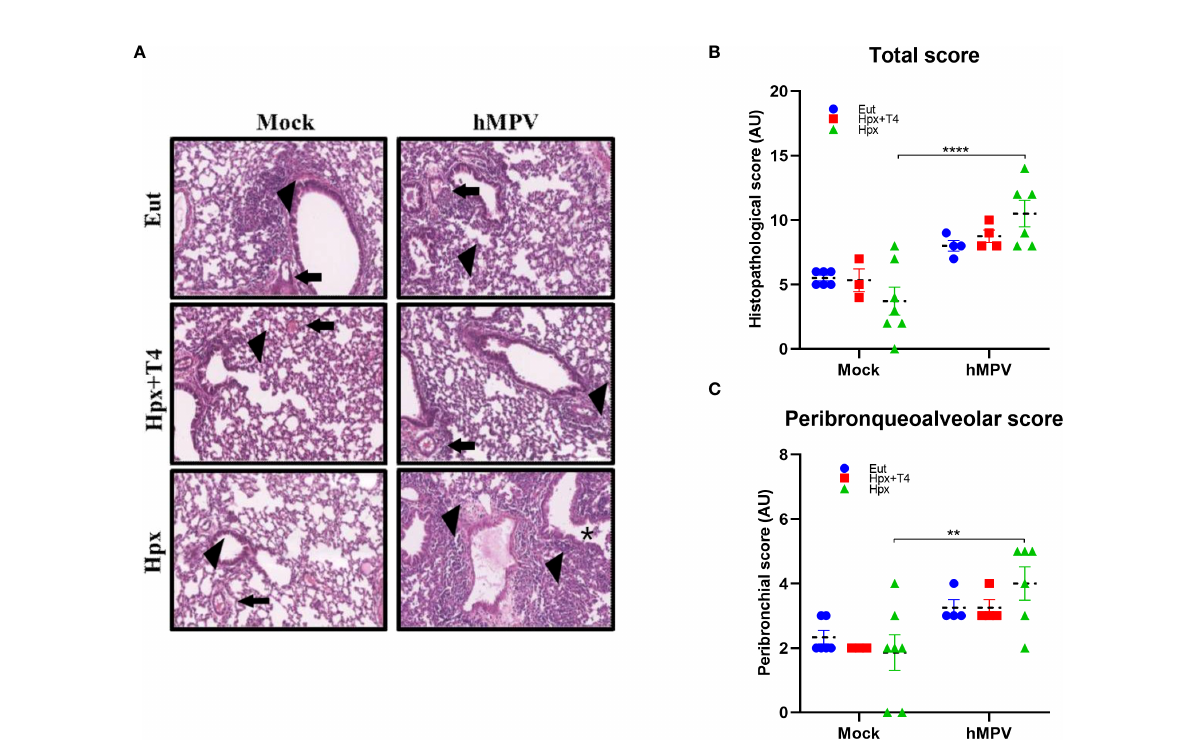
FIGURE 4 Hpx progeny tends to have a higher histopathological score after the hMPV infection. Lung sections from Eut, Hpx+T4, and Hpx male and female mice mock or hMPV infected are shown at 40X with H&E stain. A board-certi fi ed pathologist analyzed the degree of pulmonary in fl ammation for scanned slide images from each group. (A) Representative images of histological sections (600 µm) are shown. Arrowheads show peribronchial/bronchiolar in fi ltrate; arrows show perivascular in fi ltrates, and the asterisk indicates intrabronchial cells. (B) Histopathological score graph. (C) Peribronchiolar score graph. Comparisons for the same group were made using a two-way ANOVA and Tukey ’ s multiple comparisons test **p < 0.01 and ****p <